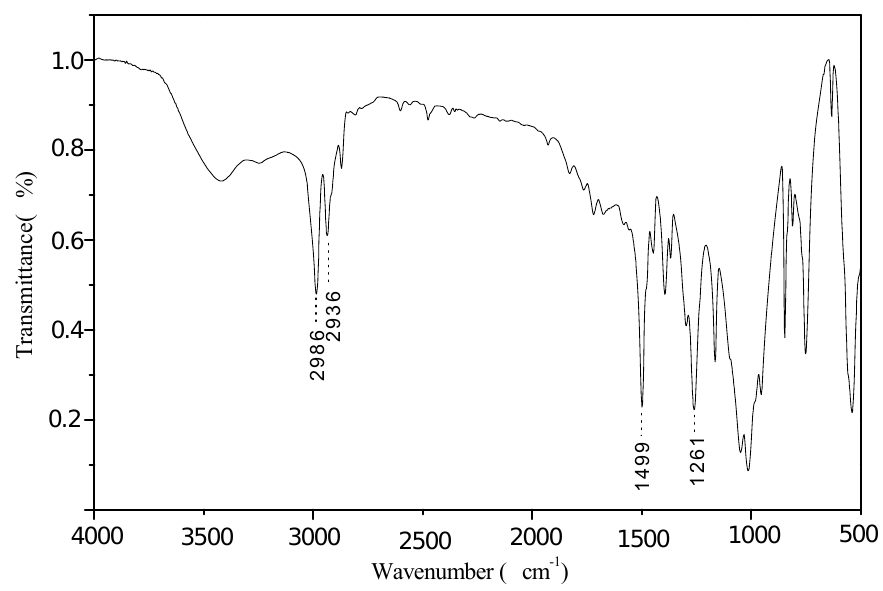
Figure 1. FTIR spectrum of compound